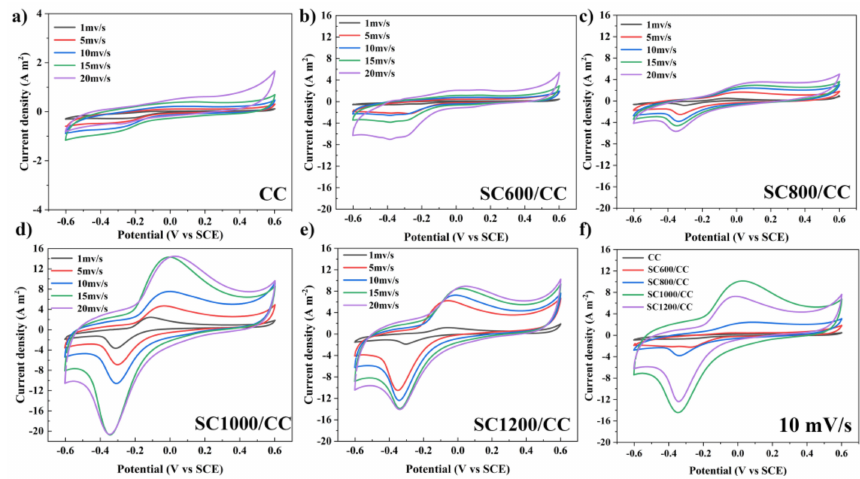
Figure 5. CV plots of ( a ) CC, ( b ) SC600/CC, ( c ) SC800/CC, ( d ) SC1000/CC, ( e ) SC1200/CC with 1, 5, 10 and 15 mV/s scanning rates and ( f ) CV plots of the electrodes with 10 mV/s scanning rates at three-electrode electrochemical systems after 54 d of batch mode